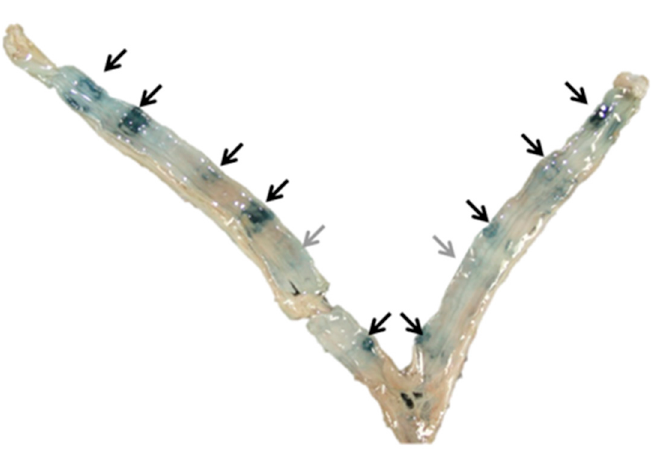
Figure 3. Uterus from a female mink with different staining intensity of placental scars (PSCs). Nine clearly visible PSCs (black arrows) and two pale scars (grey arrows).